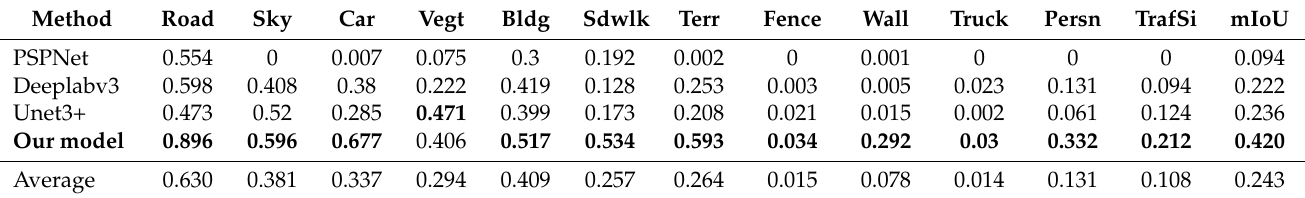
Table 8. Performance comparison of each model on the Foggy Cityscape dataset.